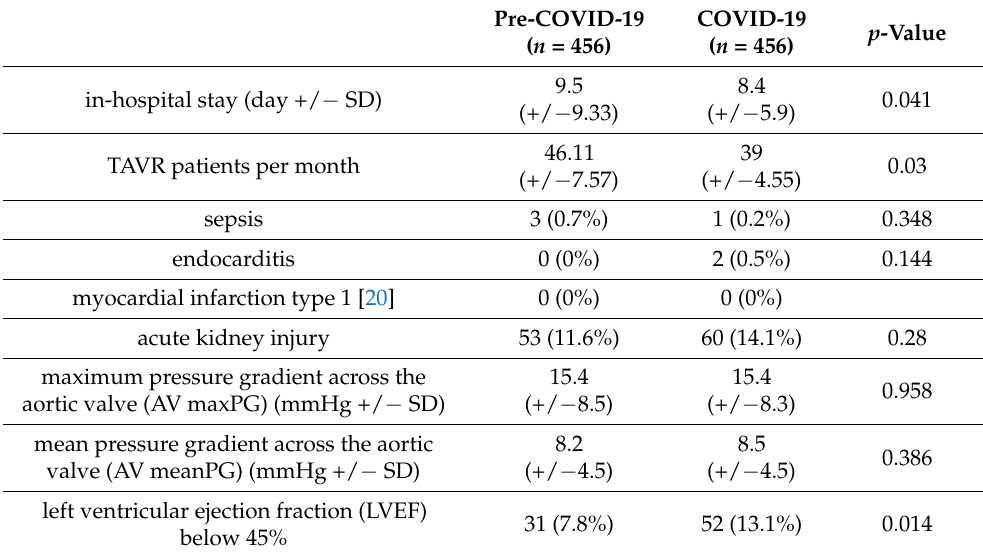
Table 9. Postprocedural data and follow-up.